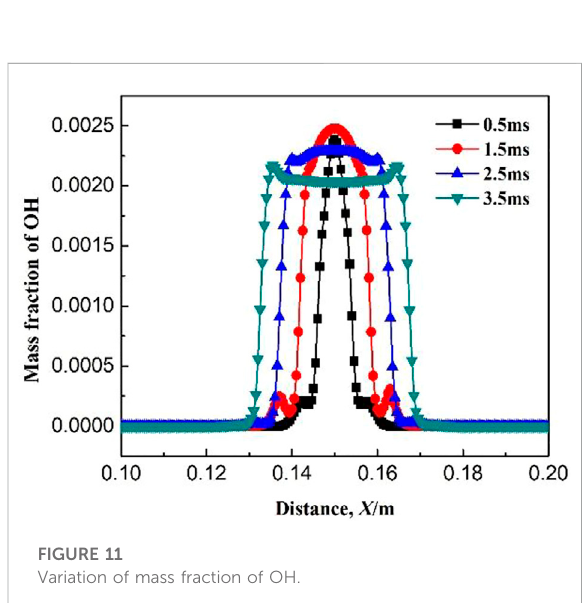
FIGURE 10 Variation of mass fraction of O.